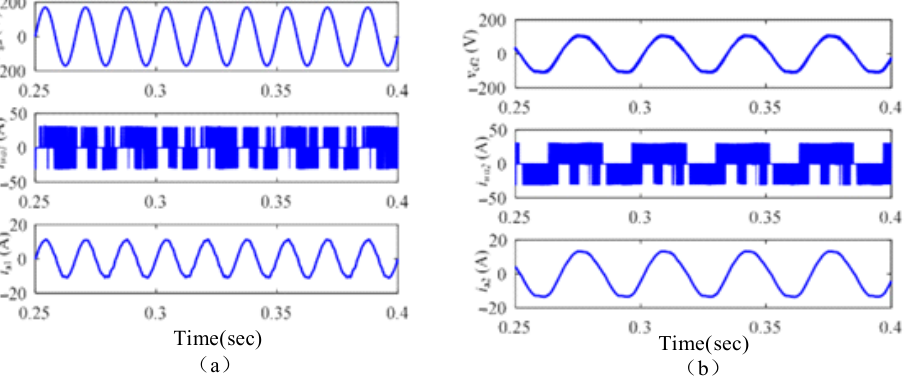
Figure 10. Performance under different fundamental frequency: ( a ) rectifier side ( b ) inverter side.